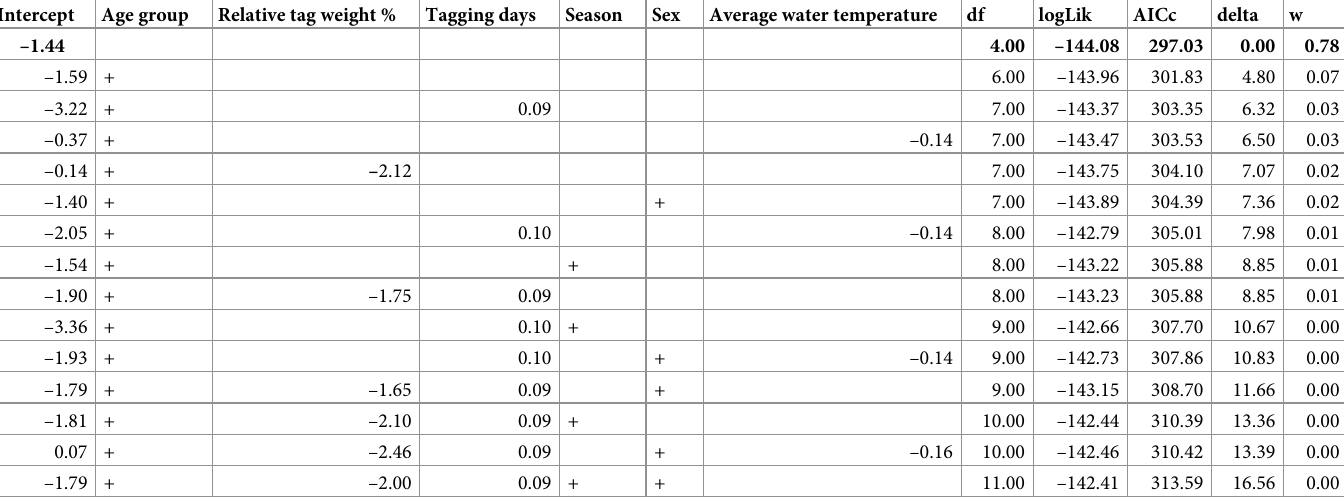
Table 4. The model selection result, investigating percentage body weight change during tagging of Eurasian beavers ( Castor fiber ) in South-Eastern Norway (2009–2020). Each model represents a linear mixed effects model with beaver ID included as a random effect. Potential fixed effects included in each candidate model are tag weight as a percent of initial beaver body mass (tag weight %), age group of the beaver, number of days tagged, season of tagging, sex, and average water temperature during the tagging period. The plus signs indicate the categorical variables included, and values are given for numerical variables that were included in each candidate model. The intercept includes the ‘young’ age group of beavers. Candidate models were ranked based on AICc, and the range of Δ AICc < 2 are shown in bold. Degrees of freedom (df), log likelihood (logLik) and AIC weight (w) is provided for each candidate